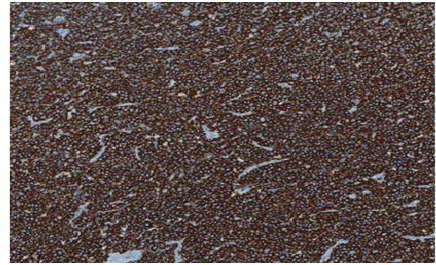
Figure 3: Breast lymphoma stained with anti-CD20 ( ×